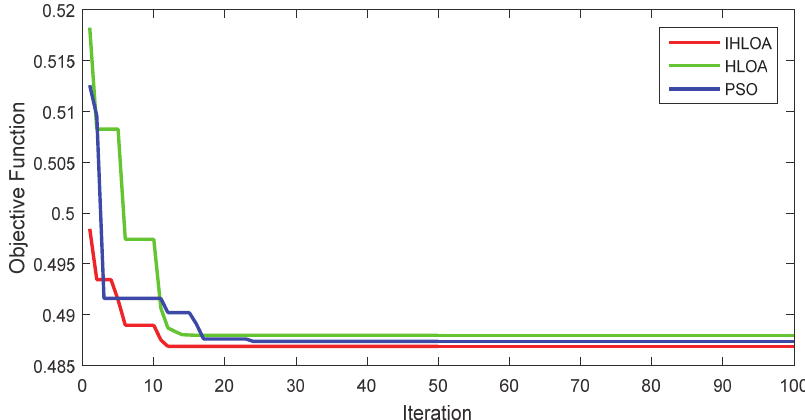
Figure 5. Convergence curve of allocation of two PV in 33 ‐ bus distribution system in the deterministic case.